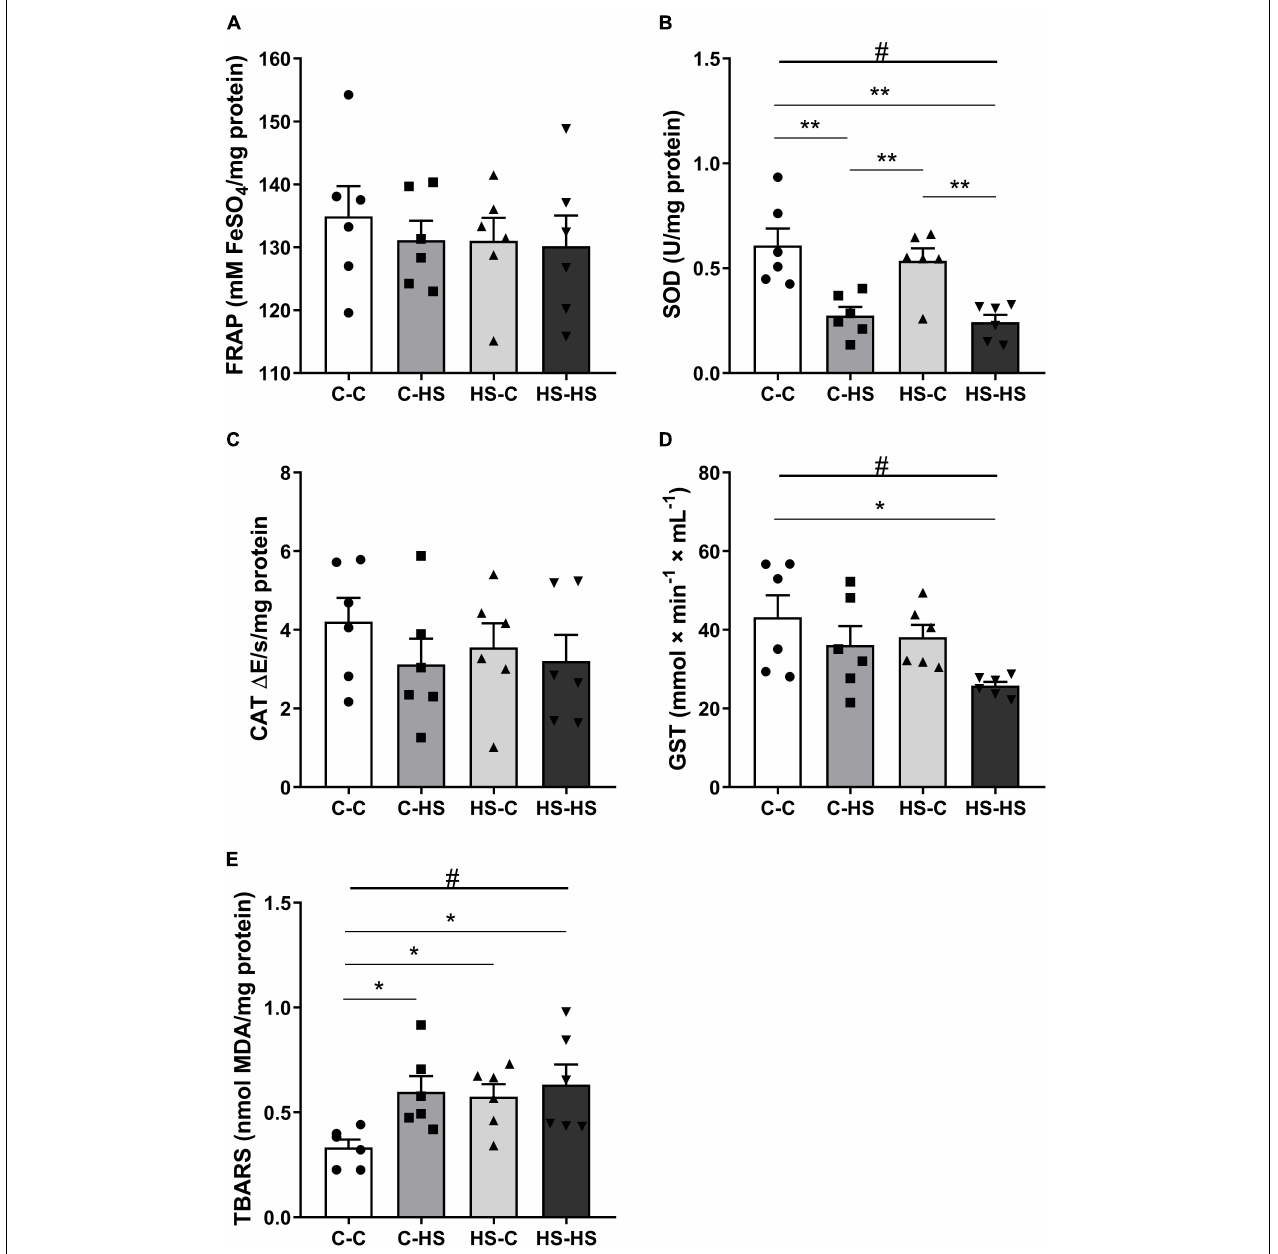
FIGURE 4 | The ferric reducing antioxidant power (FRAP) total antioxidant capacity (A) , superoxide dismutase (SOD) (B) , catalase (CAT) (C) , glutathione S-transferase (GST) activity (D) , and the thiobarbituric acid reactive substances (TBARS) (E) concentration in the amygdala. C-C, offspring of standard diet fed dams who received a standard diet after weaning; C-HS, offspring of standard diet fed dams who received a HS diet after weaning; HS-C, offspring of HS diet fed dams who received a standard diet after weaning; and HS-HS, offspring of HS diet fed dams who received a HS diet after weaning. Data are shown as mean and SEM; n = 6. # p < 0.05 (postweaning factor); * p < 0.05, ** p < 0.01 (interaction of the pre- and postweaning factors) using the ANOVA and the Newman–Keuls